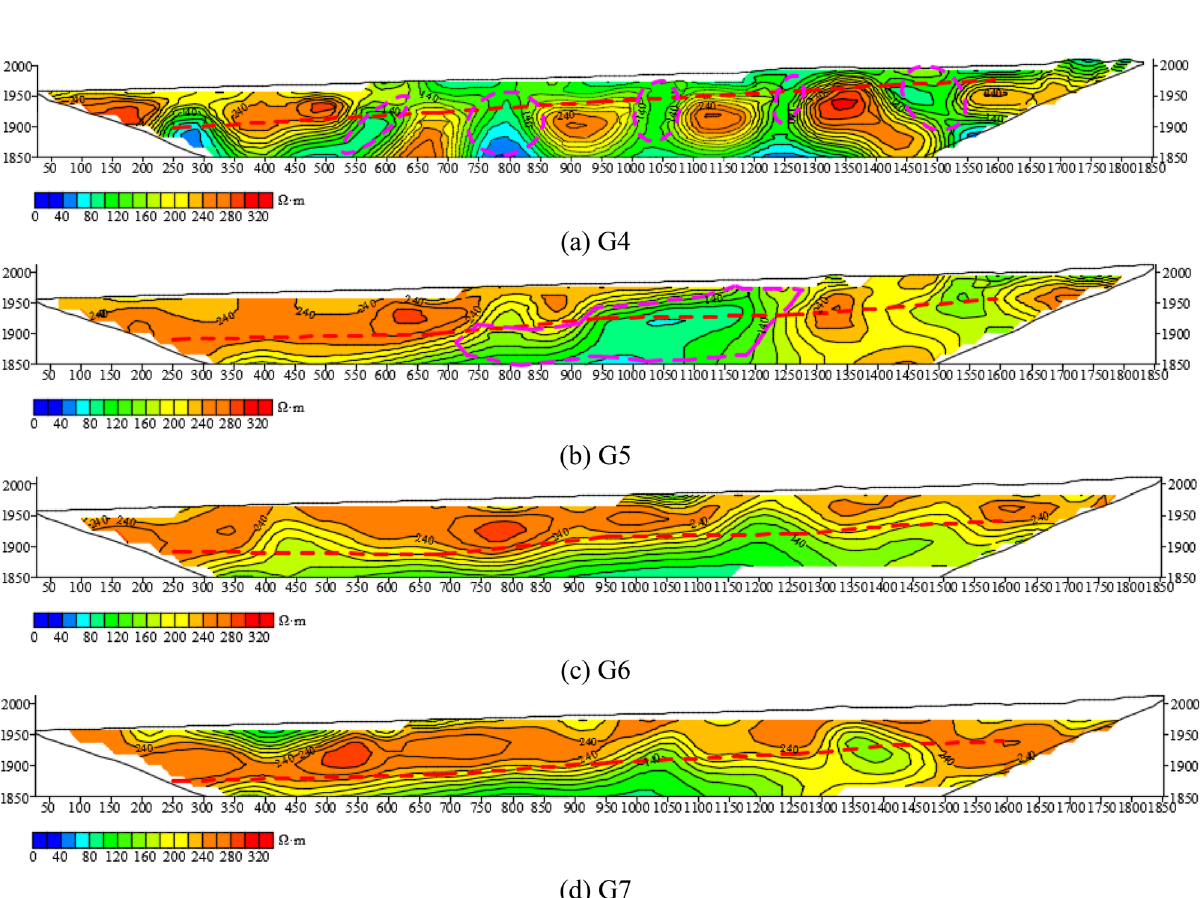
Figure 20. The resistivity profile of the HDRM of ( a ) G4, ( b ) G5, ( c ) G6, ( d )